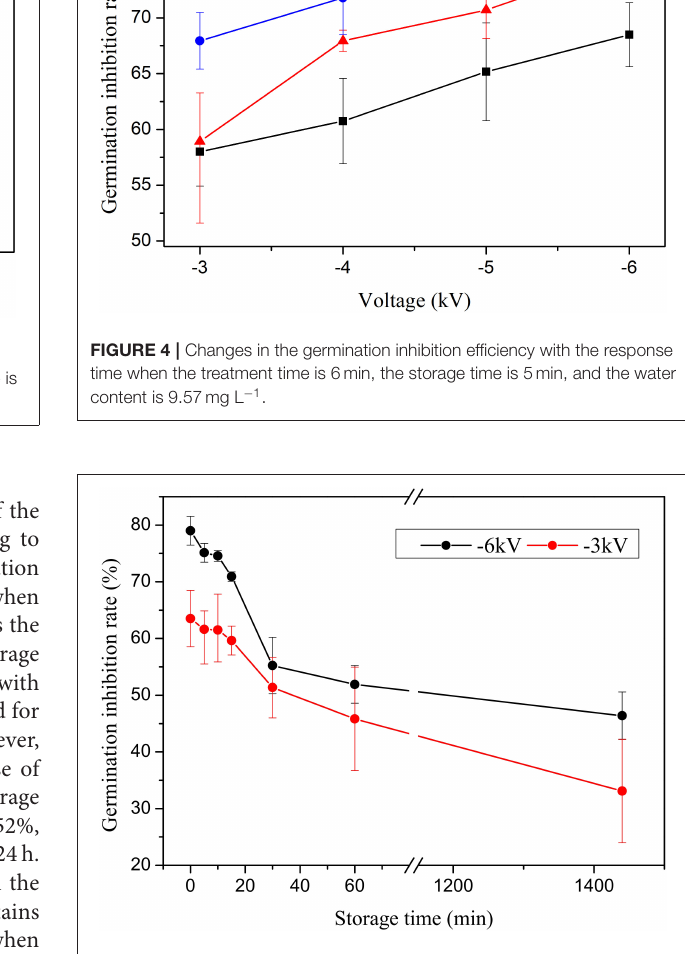
FIGURE 5 | Changes in the germination inhibition efficiency with the storage time in the case of 6min treatment time, 9.57mg L − 1 water content, and 10min response